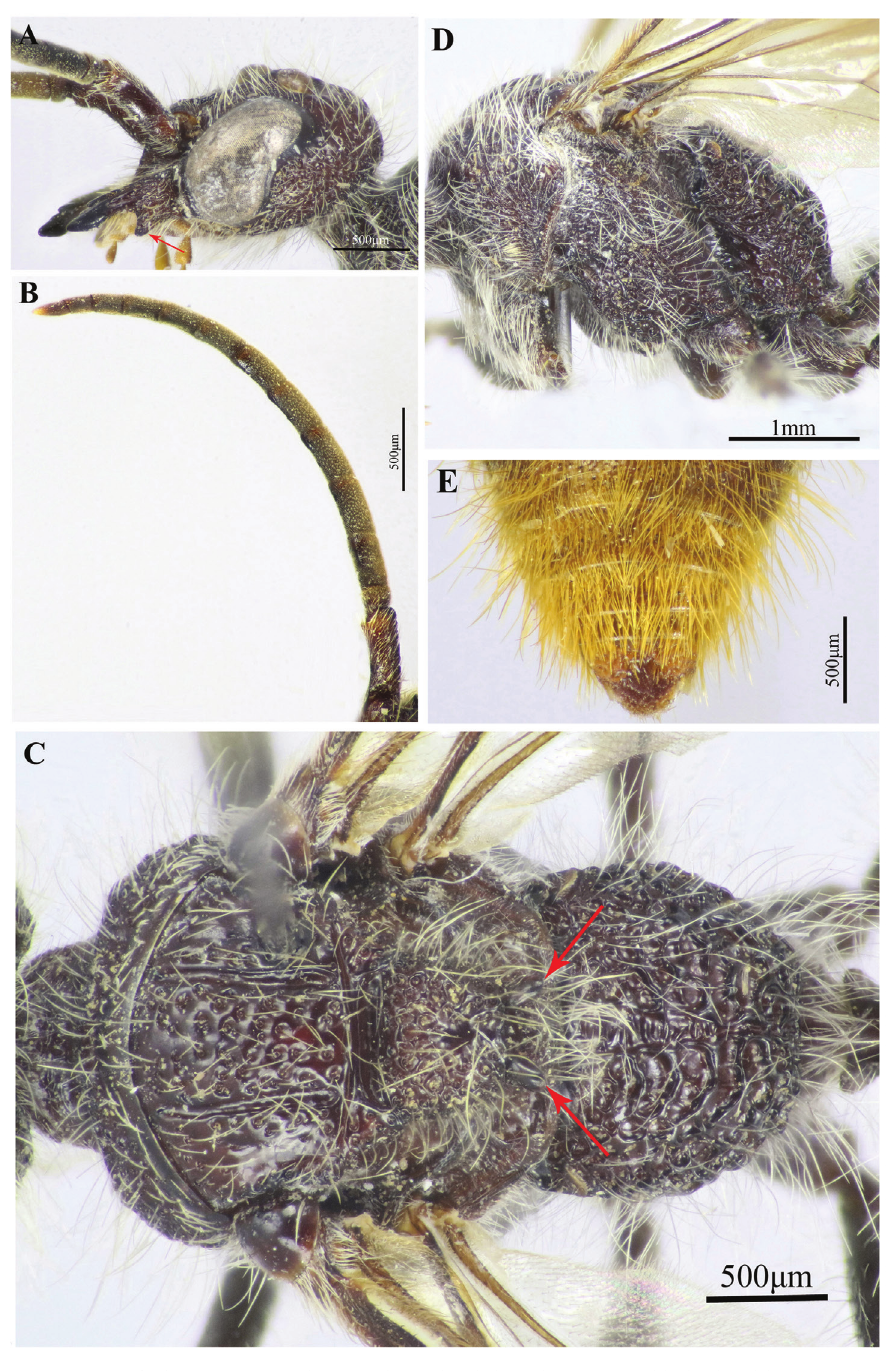
Figure 4. Pseudophotopsis aurea (Klug) (Male) A head, lateral view (mandibular basal lower tooth in- dicated) B antenna C, D mesosoma, dorsal and lateral views, respectively (metanotal horns indicated) E T3–T7, dorsal